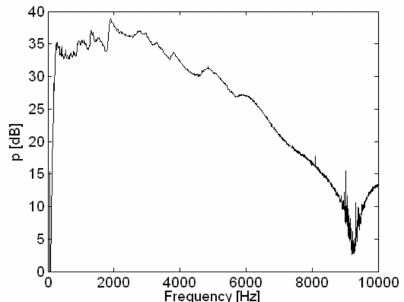
Figure 7. Spatially averaged measurement pressure of